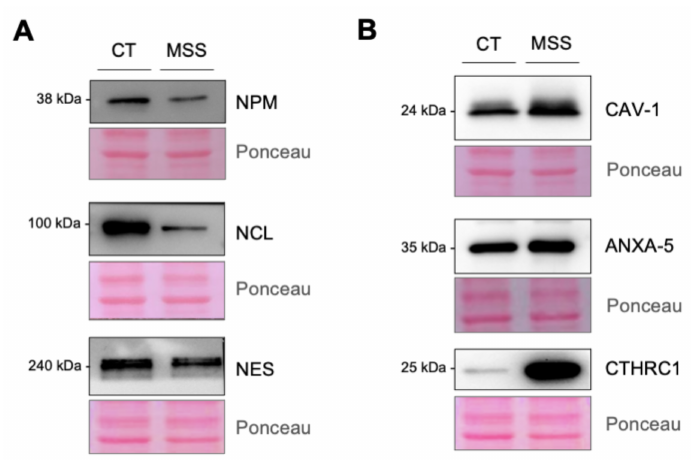
Figure 7. Western blot validation of proteomic analysis. ( A , B ) HF-CT (CT) and HF-MSS (MSS) cul- tured under standard growth conditions were analyzed by Western blotting to assess the expression of NPM, NCL, NES, CAV-1, ANXA-5, and CTHRC1 as indicated. The proteins downregulated or upregulated in HF-MSS are shown in A and B, respectively. Immunoblots are representative of at least two independent experiments. Ponceau S staining of the blots is shown to control for equal protein